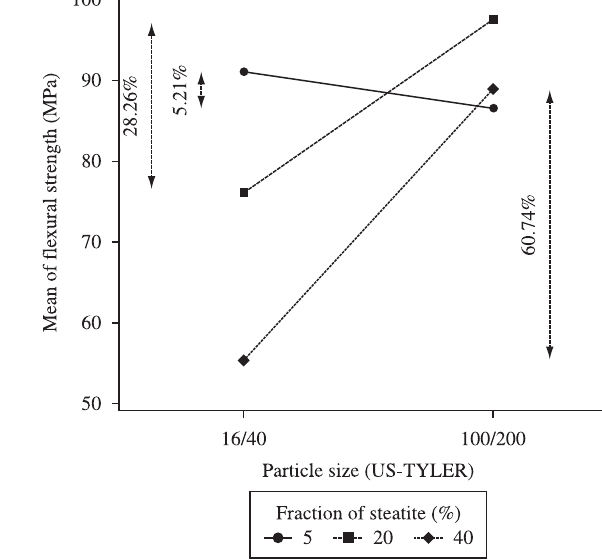
Figure 5. Interaction effect plot for flexural strength, fraction of steatite and particle size.